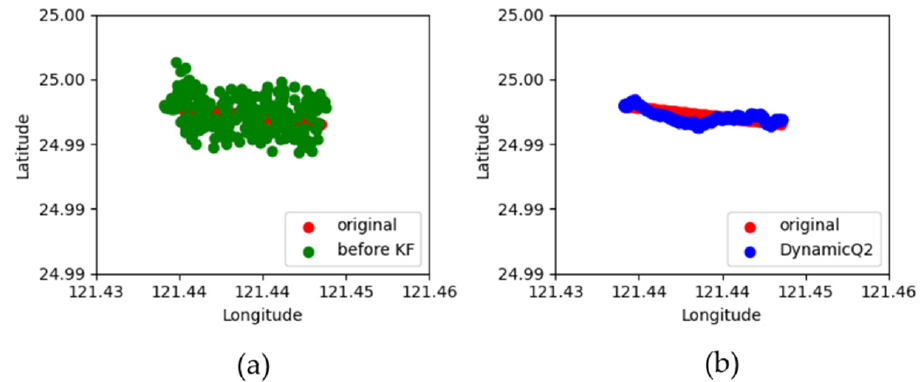
Figure 9. Simulation result of adaptive Kalman Filter. Comparison between the actual locations and the calculated locations by ( a ) using two-base station localization technique ( b ) combining two-base station localization technique and adaptive Kalman Filter.